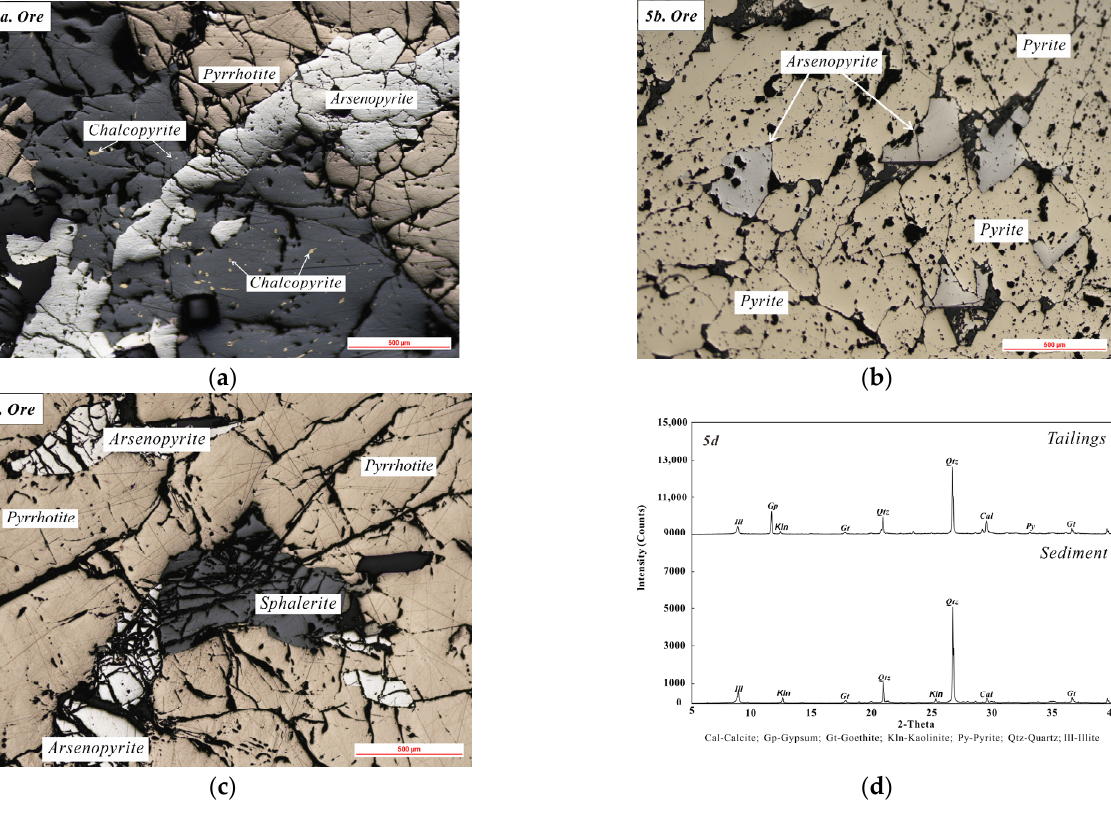
Figure 5. Mineral composition of ore, tailings, and stream sediment. ( a – c ) Show the microscopic results of rock slices, and ( d ) shows the analysis of XRD of tailings and sediments. Figure 5 reflects the mineral composition of the samples.